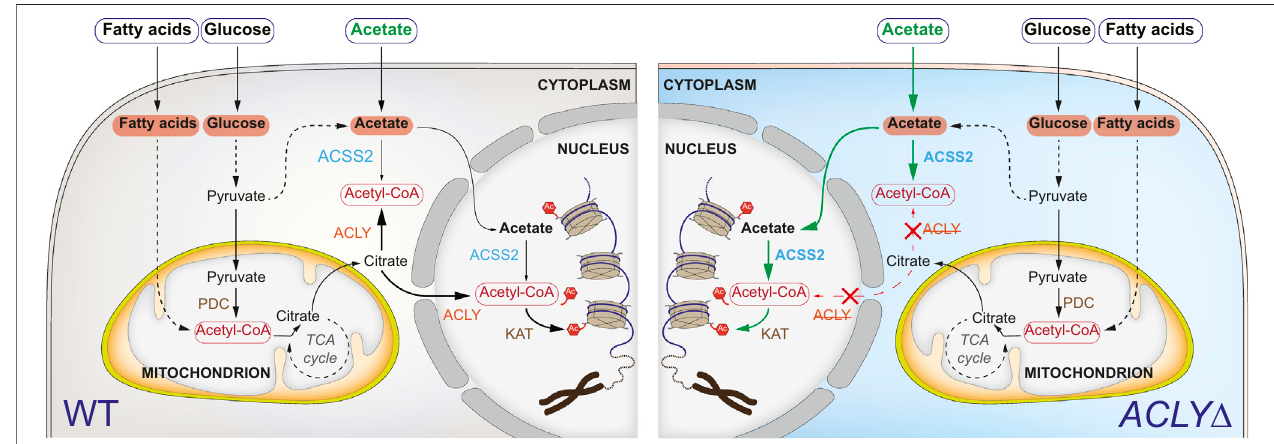
FIGURE1| Acetyl-CoAmetabolismanditsroleinKacsignaling.Simpli fi edmetabolicpathwayscontributingtoKacgeneration(left).IntheabsenceofACLY(right), the ACSS2 pathway can overcome the need for ACLY if suf fi cient acetate is available. Abbreviations: ATP-citrate synthase (ACLY), acetyl-coenzyme A synthetase (ACSS2), lysine acetyltransferase (KAT), pyruvate dehydrogenase complex